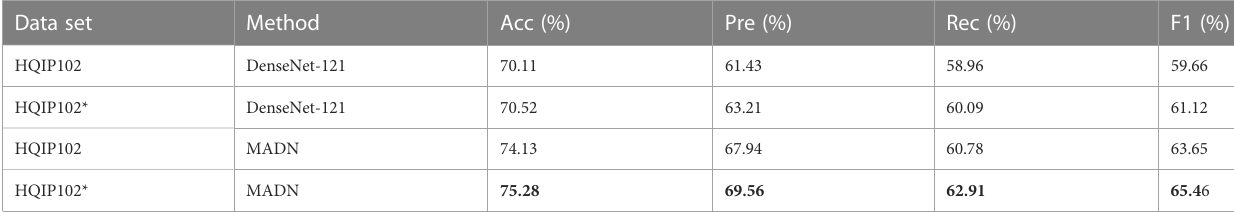
TABLE 3 Dynamic data augmentation comparison experiments.